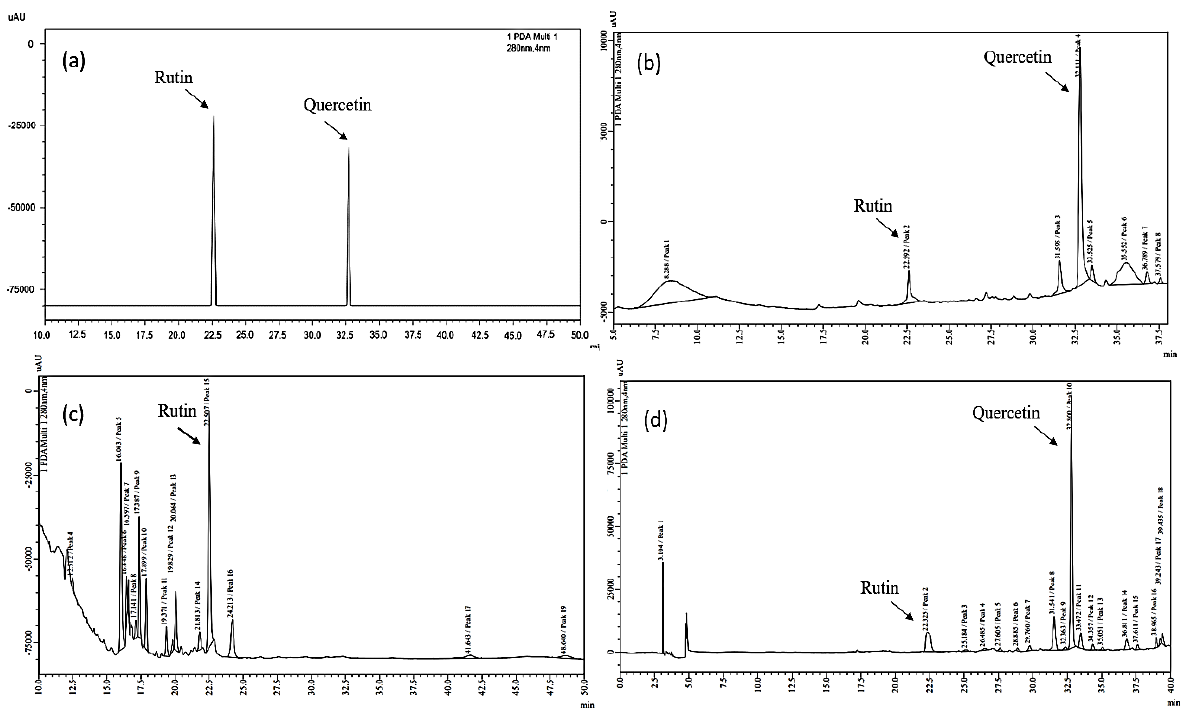
Figure 6. HPLC chromatograms of ( a ) quercetin and rutin as standards, ( b ) U. dioica , ( c ) Capsella bursa-pastoris , and ( d ) Inula racemosa were recorded at 280 nm.